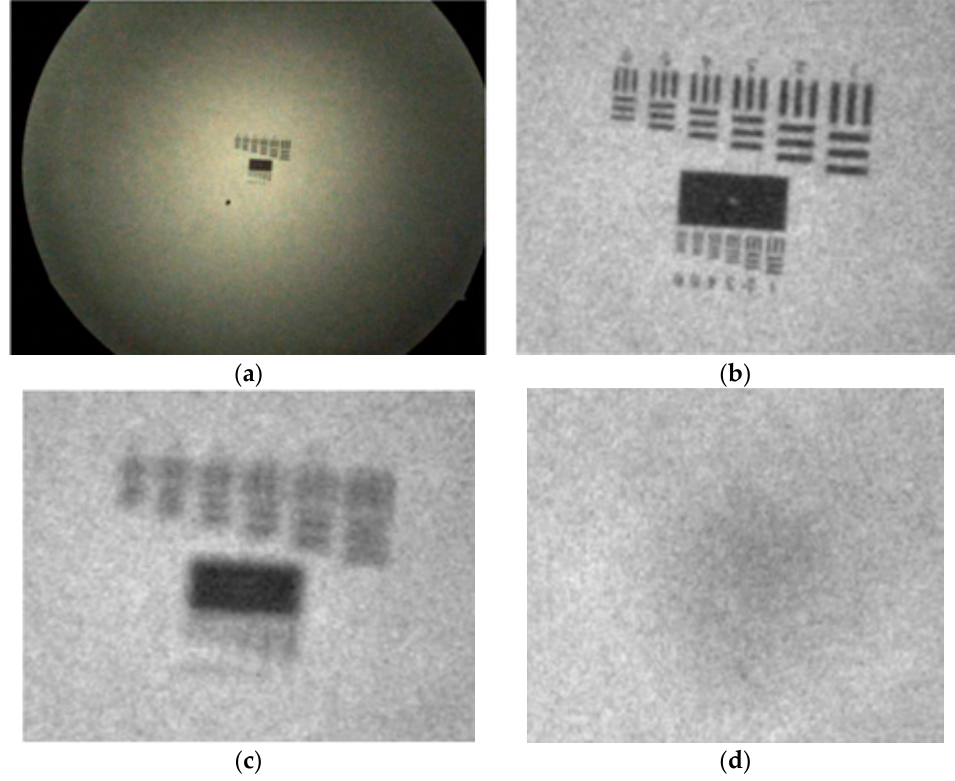
Figure 2. Image preprocessing. ( a ) Initial image; ( b ) Sharp image (correctly focused); ( c ) Blurry image (slightly out of focus); ( d ) Blurry image (severely out of focus).